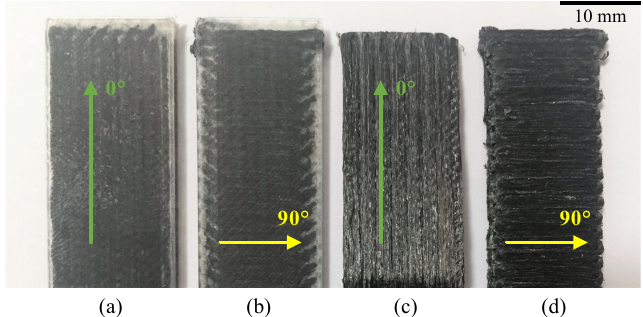
Figure 3. 3D printed CF/PA6 bending test specimens with 0° and 90° fiber direction. Specimens ( a , b ) before and ( c , d ) after removal of nylon top and bottom layers. The nylon layers (low strength and surface hardness) reduced the measured flexural modulus and were therefore removed.